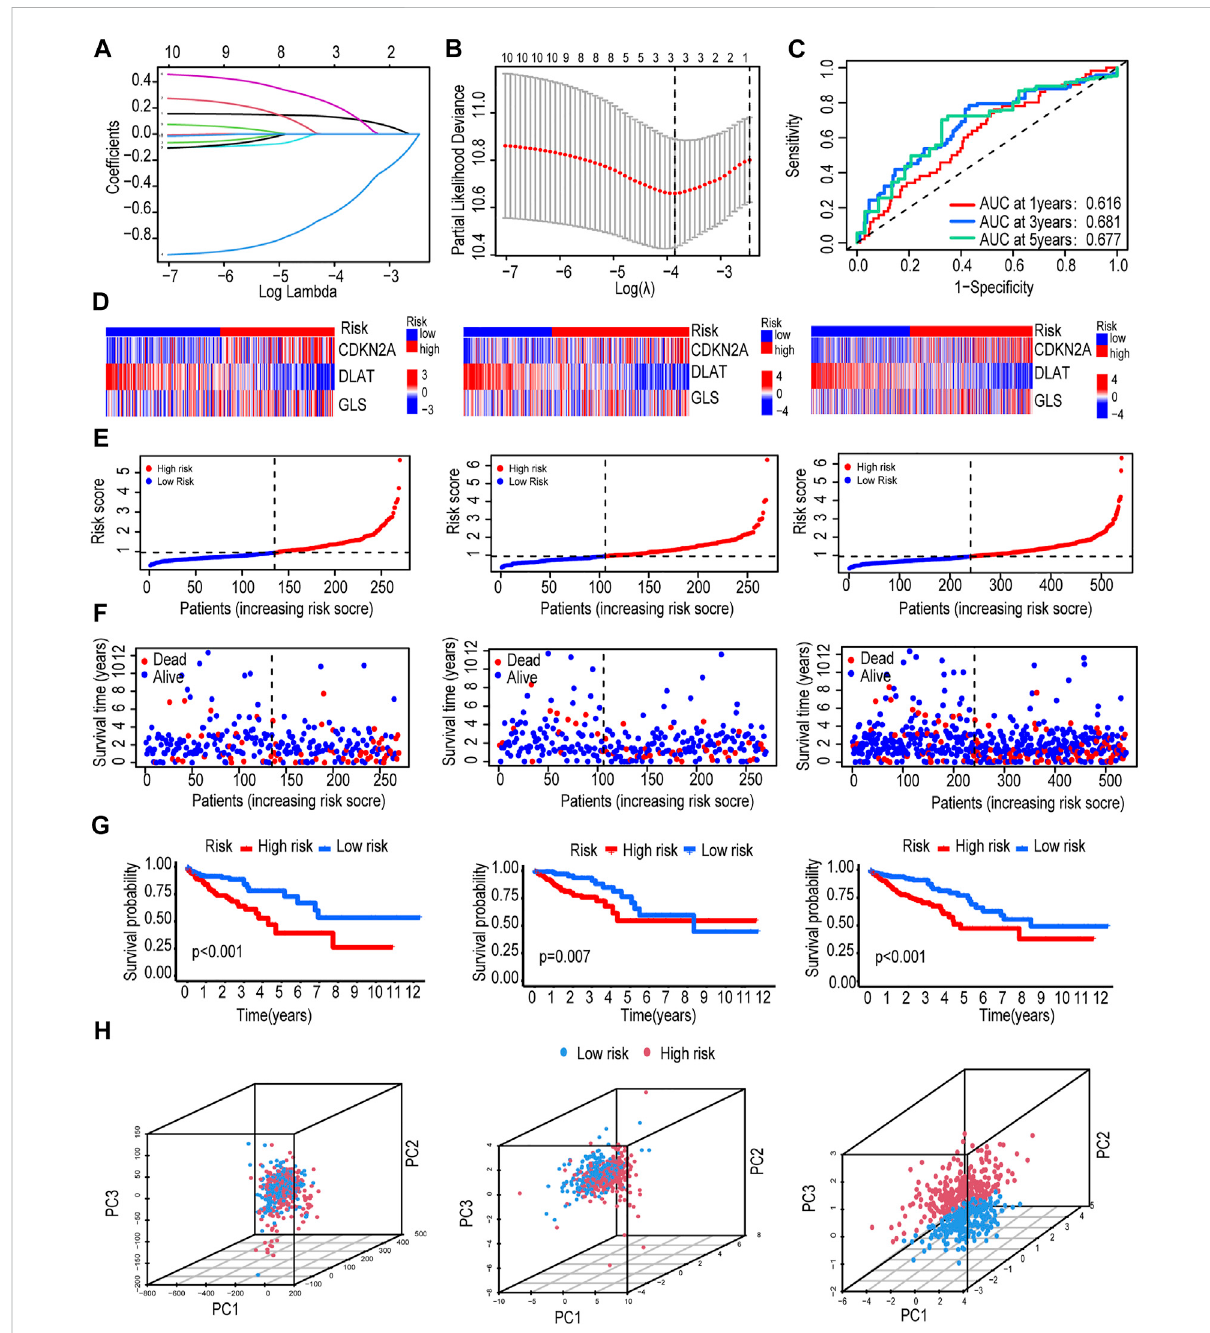
FIGURE 2 Construction and evaluation of the CRG risk score signature. (A,B) Use iterative LASSO to construct a CRG risk score signature. (C) Time- dependent receiver operating characteristic (ROC) curve validated the prognostic performance of CRG-Score. (D) Heatmap of the expression of 3 CRGs in train group, test group and total group. (E) CRG-Score distributionin train group, testgroup and total group. (F) CRG-Score survival status in train group, test group and total group. (G) Survival time between CRG-Score groups in train group, test group and total group. (H) Principal component analysis